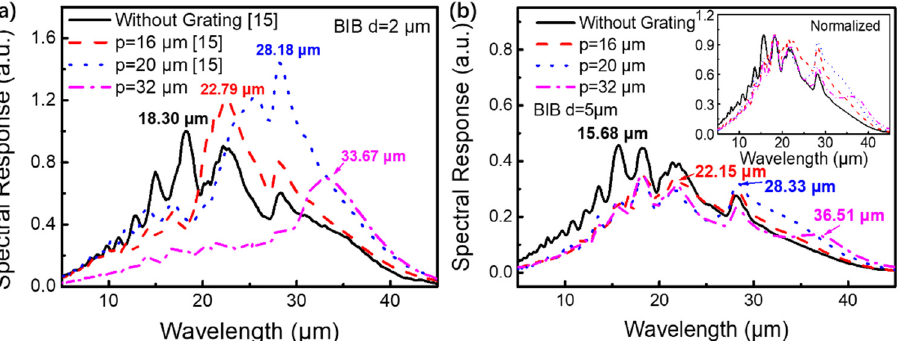
Figure 4. Experimental response spectra of the Si-based BIB detectors covering with and without 16, 20, and 32 µ m periods of metal gratings, in which the thicknesses of the BL are ( a ) 2 µ m and ( b ) 5 µ m, respectively. The black, red, and blue spectra curves in ( a ) are reprinted with permission from Ref. [15]. 2022, Applied Physics Letters. The inset image in ( b ) is the normalized response spectra.